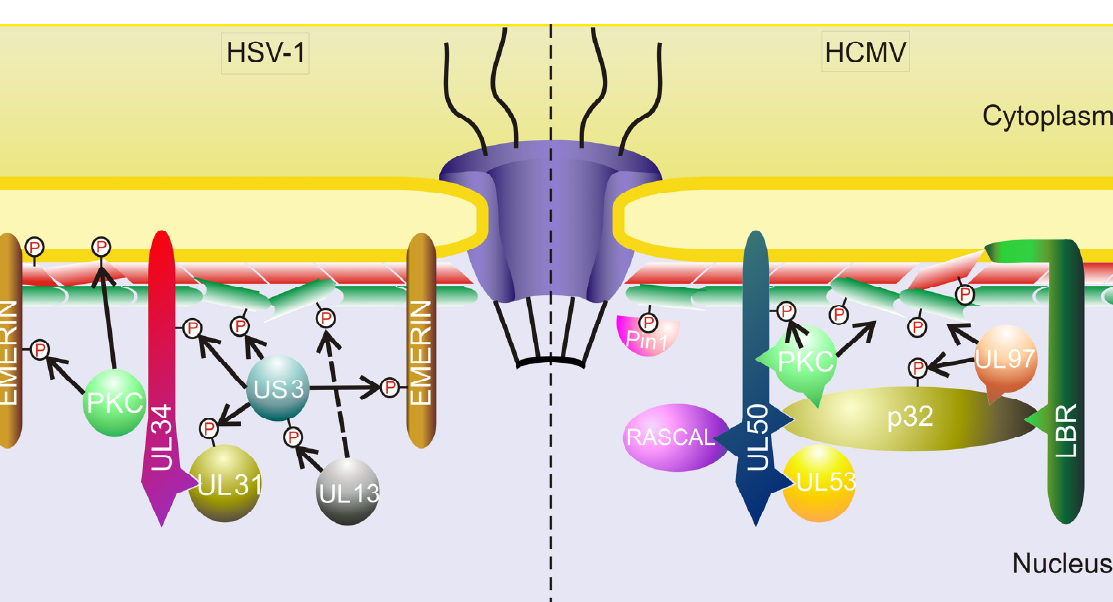
Figure 1. Nuclear egress complex of herpes simplex virus 1 (HSV-1) and human cytomegalovirus (HCMV). The lamin proteins are depicted as two layers beneath the nuclear membrane (lamin B in red, lamin A/C in green). The red “P” in circle marks phosphorylated proteins, actions of individual protein kinases are represented by black arrows. The dashed arrow suggests hypothetical phosphorylation of lamins by pUL13 kinase (proved for HSV-2). The lamin B receptor protein is abbreviated as “LBR”. Besides PKC, other cellular kinases may be involved in phosphorylation of nuclear lamina